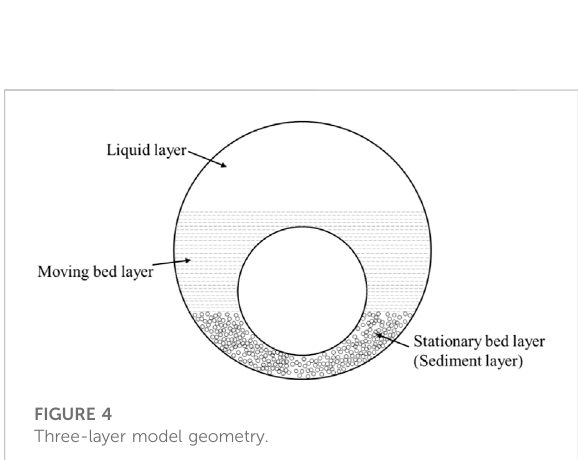
FIGURE 4 Three-layer model